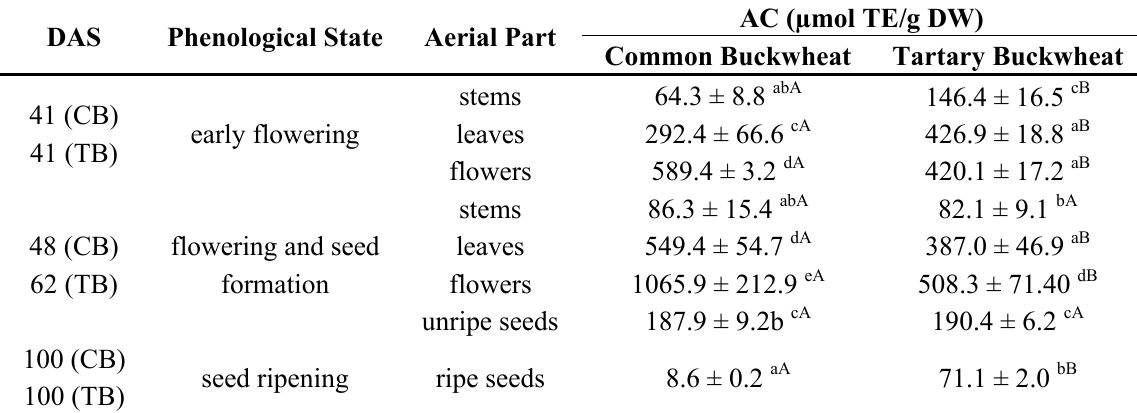
Table 4. Phenological state and antioxidant capacity (AC) of the aerial parts of common (CB) and tartary (TB) buckwheat provided by PCL